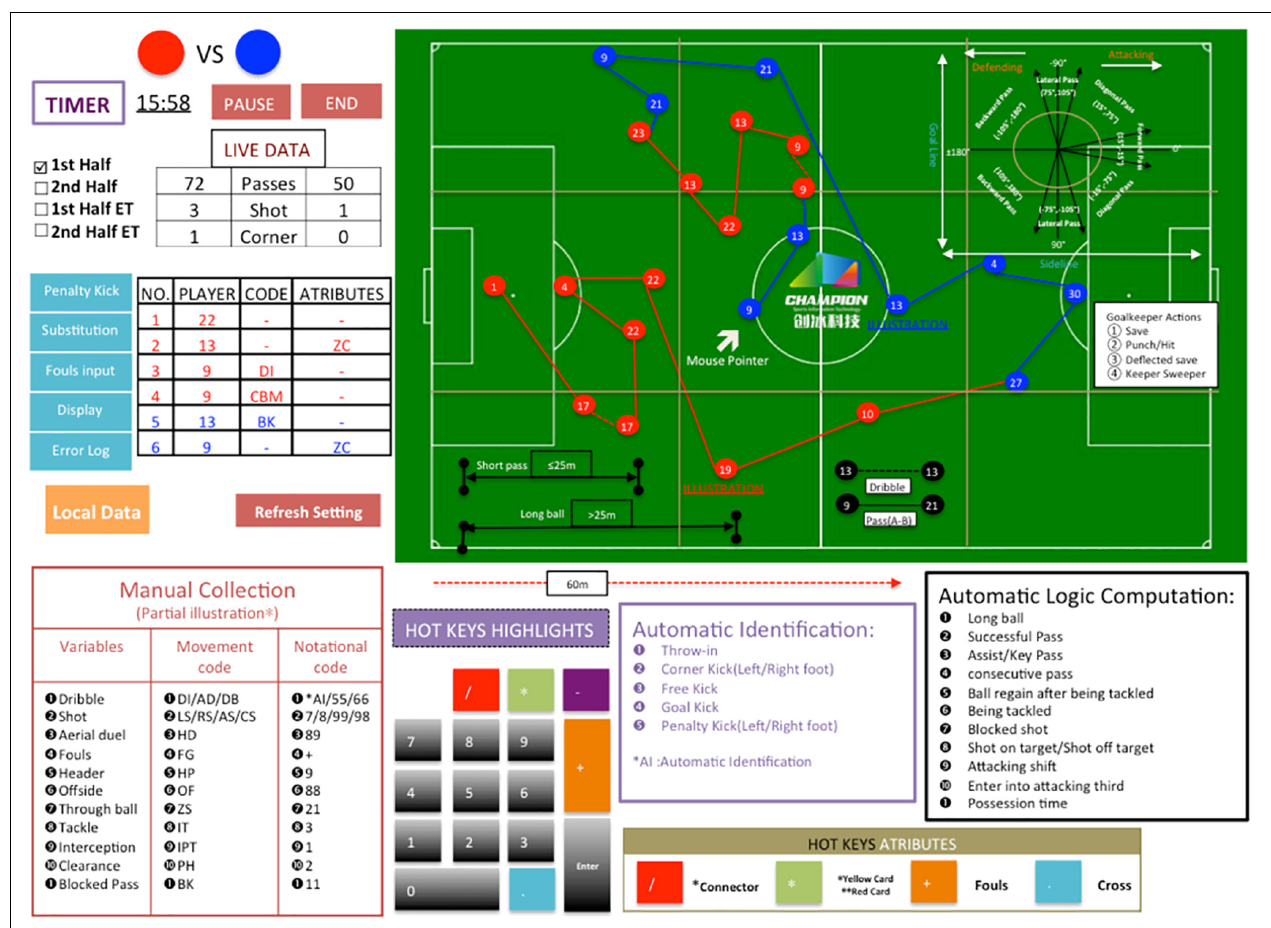
FIGURE 1 | Illustration of Champdas Master System operation interface diagram.